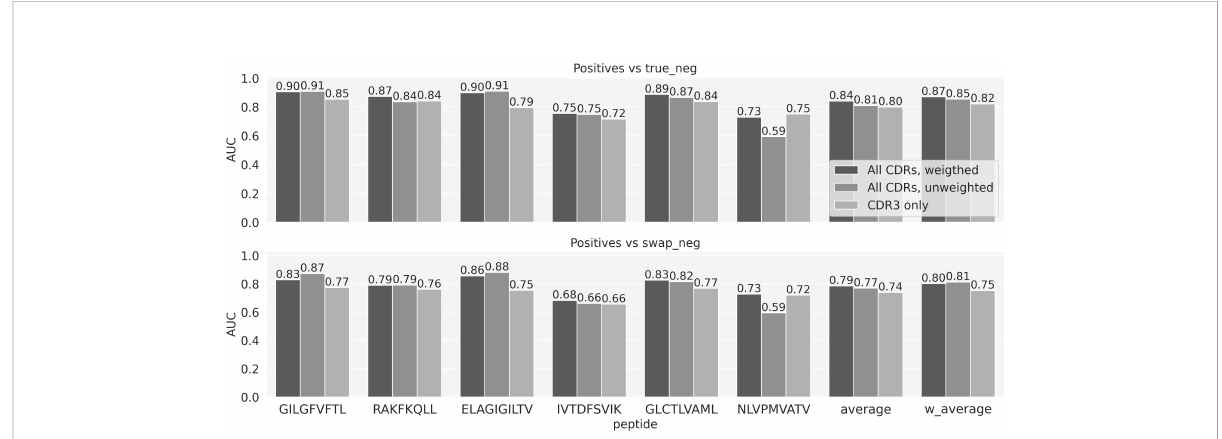
FIGURE 1 Baseline model performance for weighted and unweighted CDRs. Performance is reported as the AUC for each individual peptide, as well as the average and weighted (by number of positive TCRs) average AUC over the 6 peptides. The performances of three version of the baseline are shown: weighted, where the similarity is given by the weighted sum of the similarities of the three CDRs using the weights [1, 1, 4]; unweighted where all the CDRs are given equal weights; CDR3 only baseline, where CDR1 and 2 are given a weight of